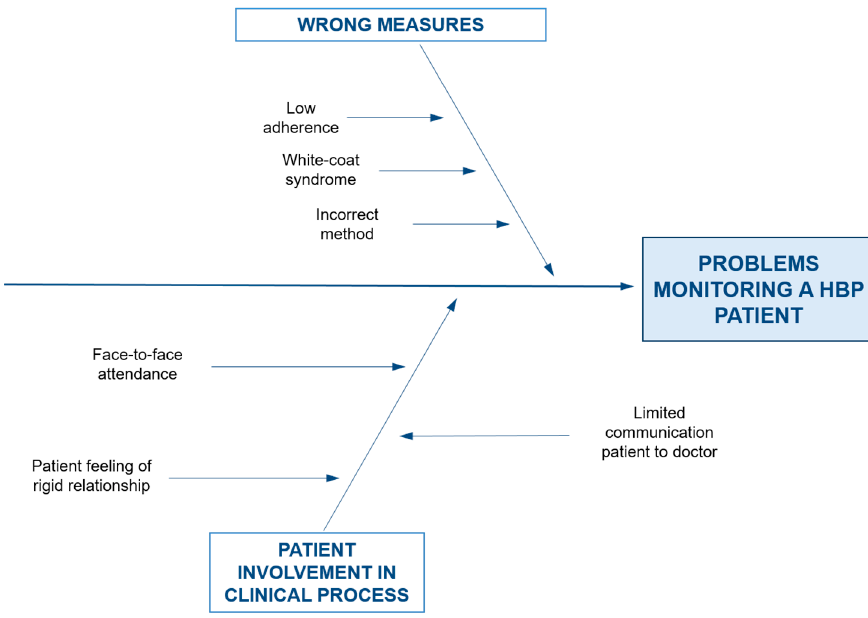
Figure 2. Ishikawa diagram for weaknesses identified in the HBP process.